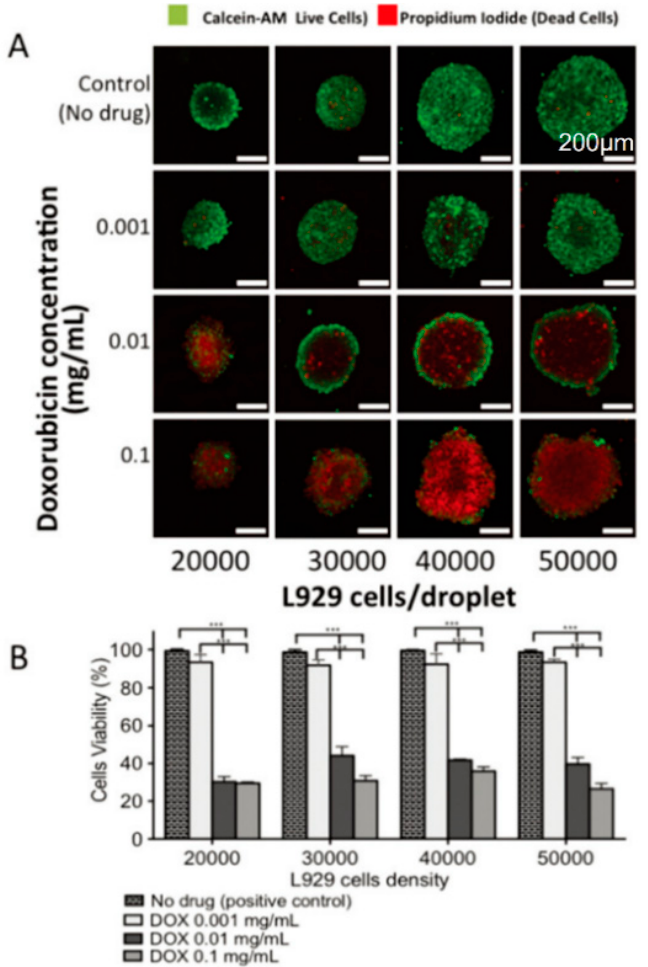
Figure 10. ( A ) After being treated with different concentrations of doxorubicin, fluorescence images of the L929 cell spheroids with different densities were obtained using confocal microscopy. ( B ) Cell viability in the 3D spheroids using different cell densities and concentrations of doxorubicin, obtained using imageJ analysis. (Reproduced from Reference [29]).